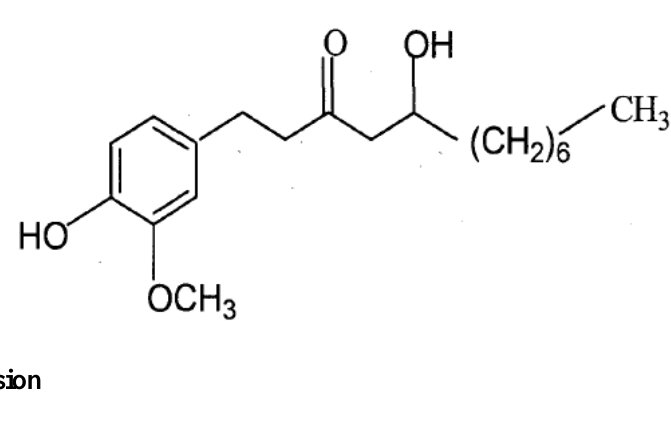
Figure 1. Structure of